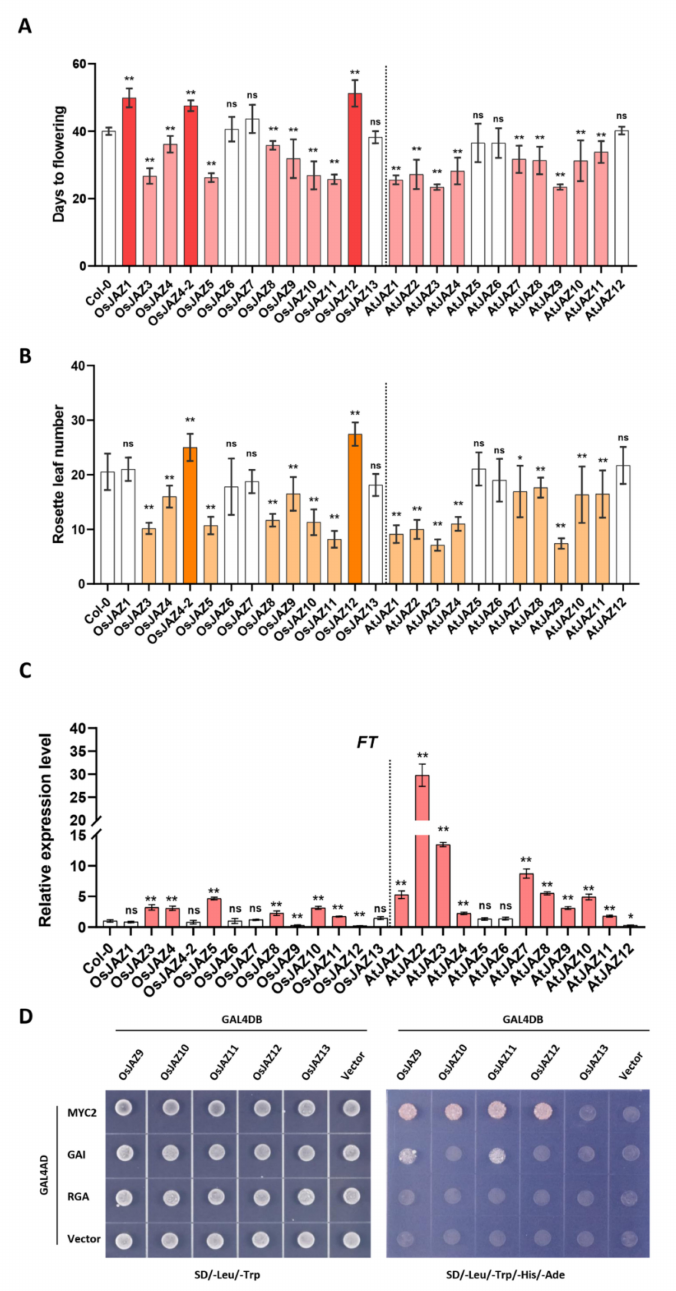
Figure 1. Function of JAZs in flowering phenotypes. ( A ) plant flowering time. The dark red column represents that the transgenic line flowered later than Col-0, the light red column represents that